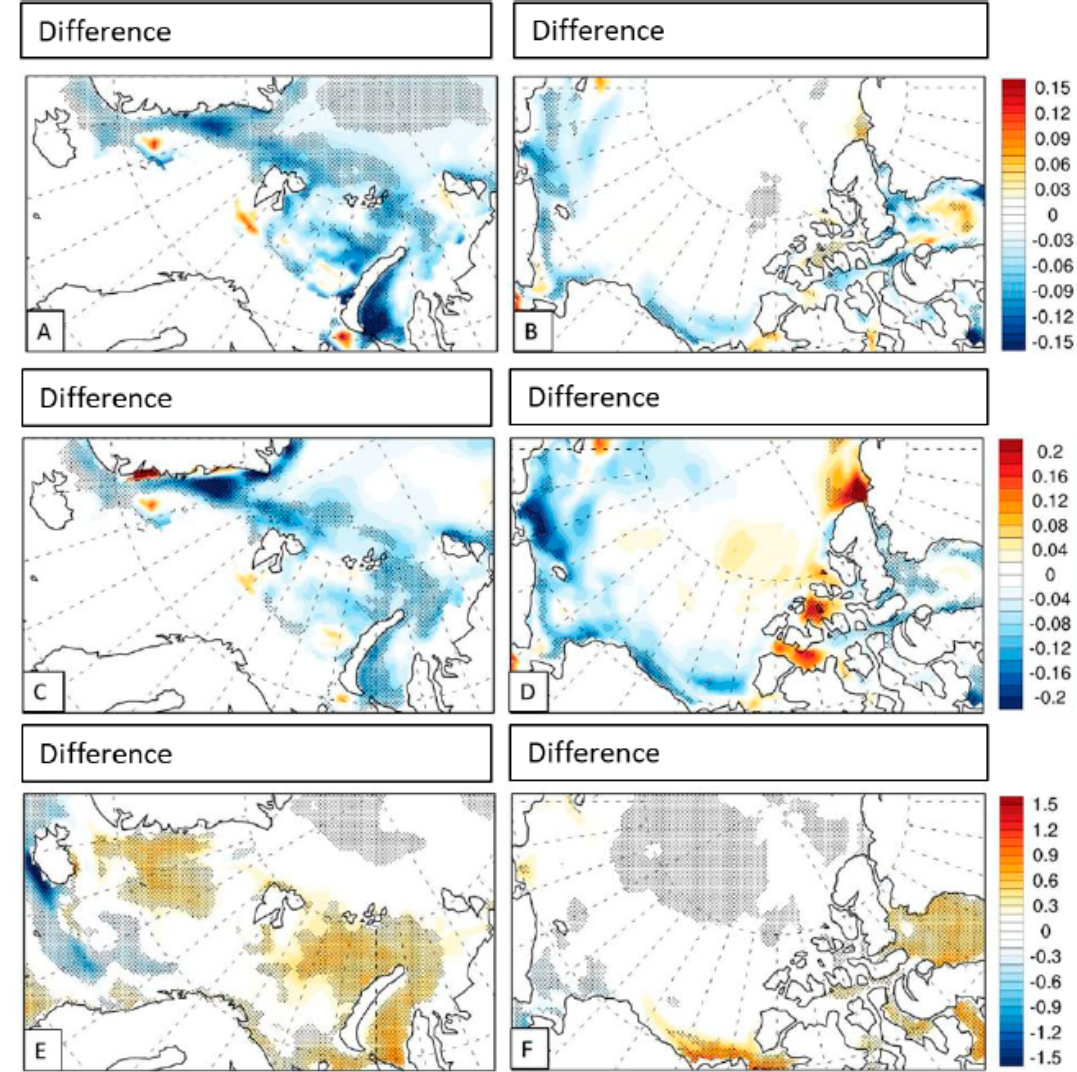
Figure 5. Differences of the composite analysis of sea-ice concentration (unit: %) between the anomalously high and low counts of the summer intense storms over ( a ) the Atlantic Arctic Ocean for the period of 1948–2008; and ( b ) the Pacific Arctic Ocean. ( c ) and ( d ) are the same as (a) and (b) but for sea ice thickness (unit: m). ( e ) and ( f ) are the same as (a) and (b) but for sea surface temperature (unit: °C). The values at a 95% confidence level are dotted.